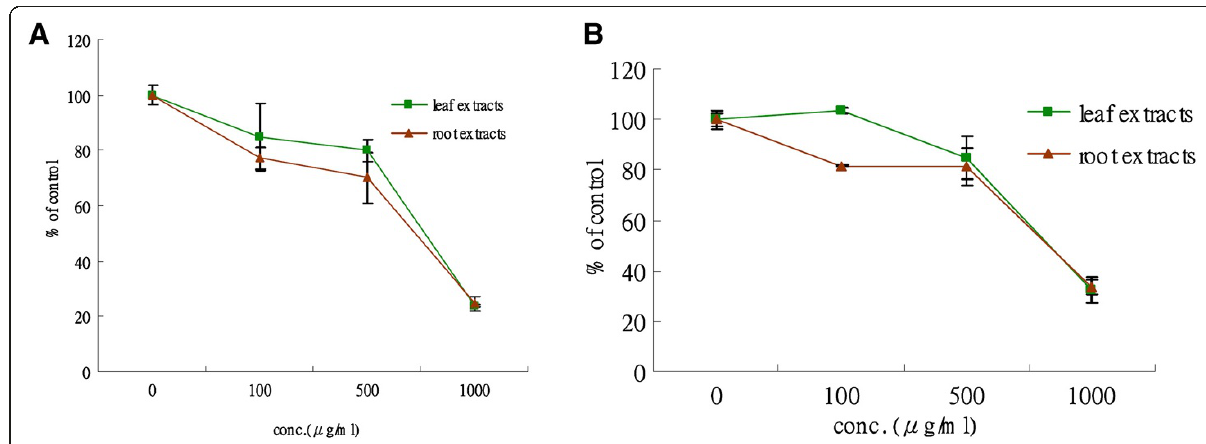
Figure 3 Effect of P. indica leaf or root crude aqueous extract on cell proliferation and viability of cancer cells as determined by MTS assay. MTS assay of ( A ) GBM8401 cells and ( B ) HeLa cells after 0, 100, 500, and 1000 μ g/ml P. indica leaf or root aqueous extract treatment. Each experiment was done in triplicate. Data are expressed as mean ±